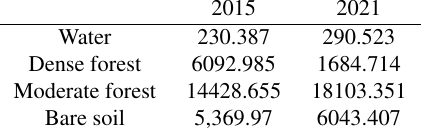
Table 2: Area changes across different categories